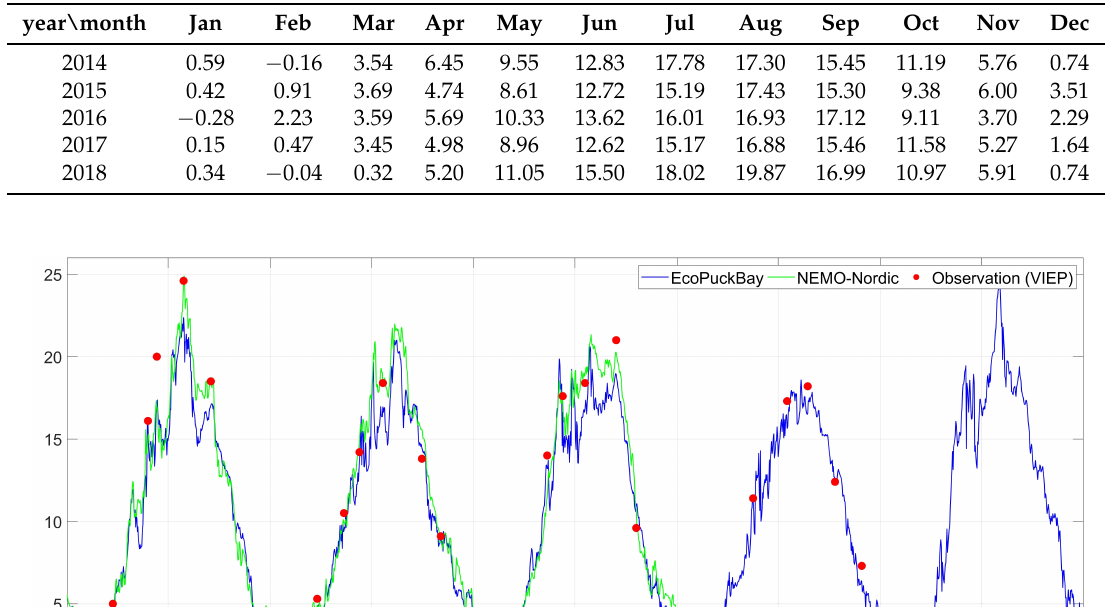
Table A2. Monthly minimums for surface temperature for the years 2014–2018.